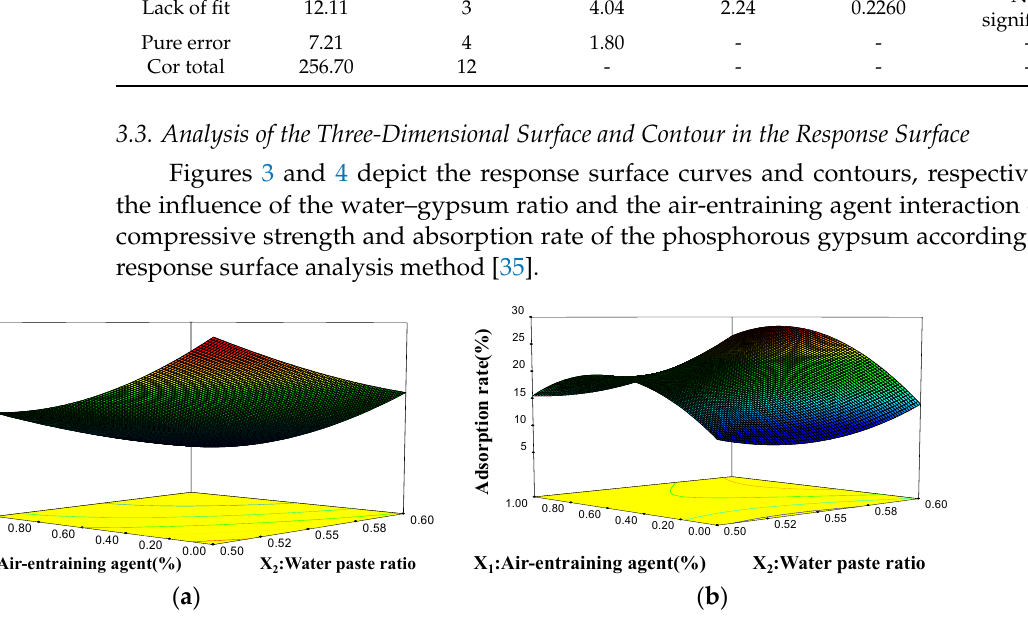
Figure 3. Response surface curves of the influence of the water–paste ratio and the air-entraining agent interaction on the compressive strength and adsorption rate of the phosphorous gypsum: ( a ) compressive strength and ( b ) adsorption rate response surface curves.